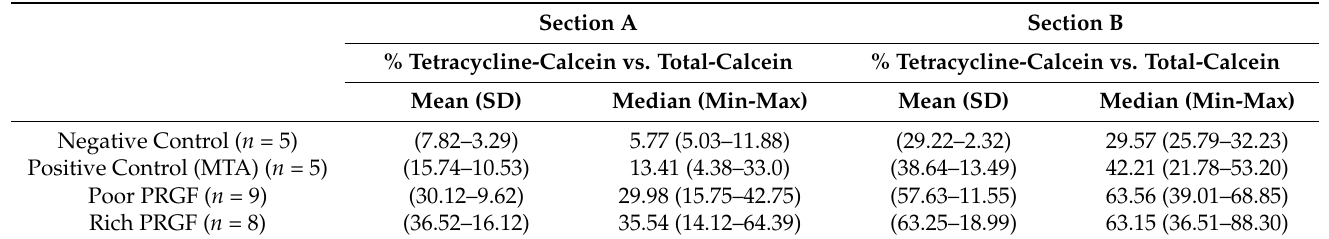
Table 1. Mean and median of the percentages for A and B